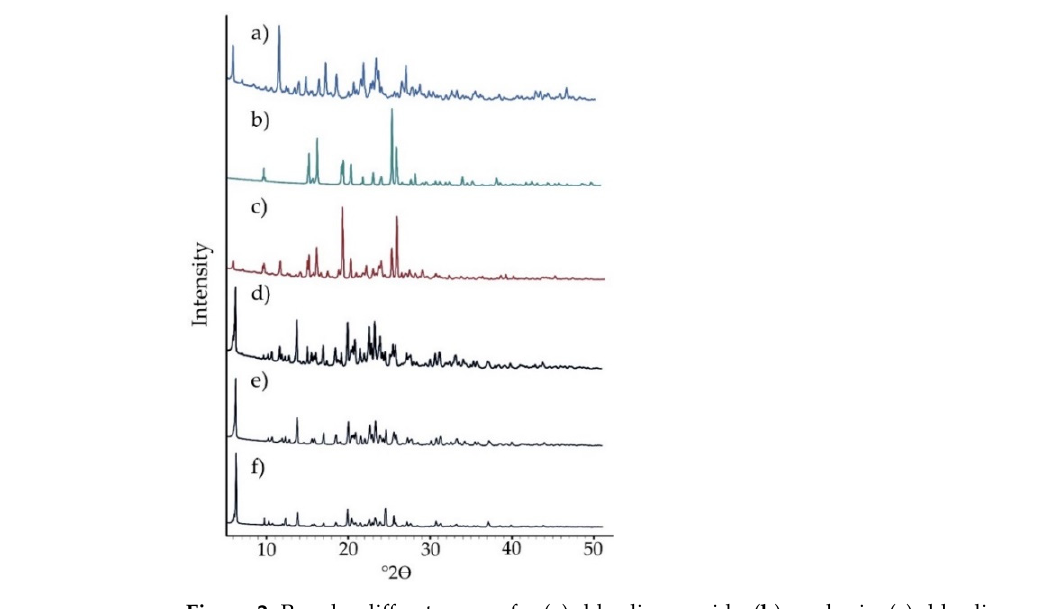
Figure 2. Powder diffractograms for ( a ) chlordiazepoxide, ( b ) saccharin, ( c ) chlordiazepoxide mixture with saccharin, and saccharin salts of chlordiazepoxide prepared using the following methods: ( d ) liquid-assisted grinding, ( e ) crystallization from ACN, and ( f ) crystallization from MeOH/ClMe. Table 1. Selected powder X-ray crystallographic data for chlordiazepoxide, saccharin, chlordiaze- poxide mixture with saccharin, and saccharin salts of chlordiazepoxide prepared by various methods.